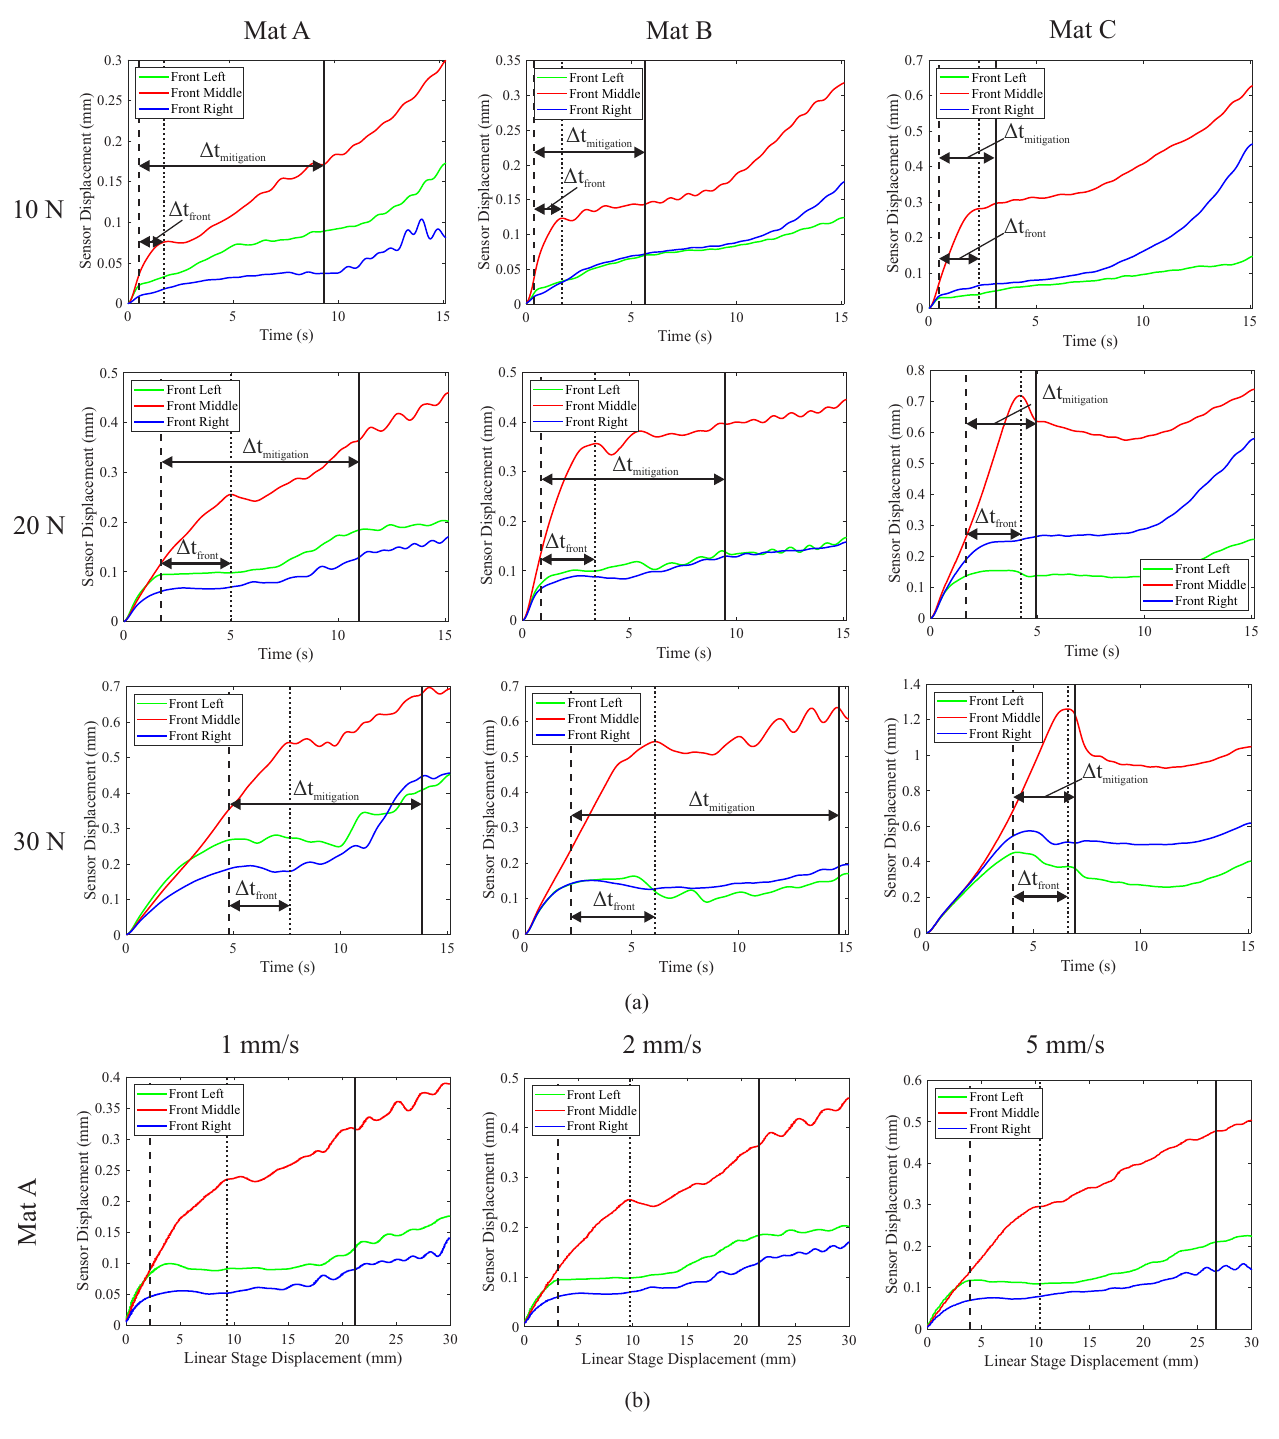
Figure 5. Graphs showing typical sensor displacements. The vertical dashed and dotted lines indicate the time slip was first detected at the outer and middle islands, respectively, whereas the solid vertical line indicates the time of macro slip. The horizontal arrows indicate the time difference between the detection of incipient slip and the occurrence of macro slip ( ∆ t mitigation ), and the time between the detection of incipient slip of one of the front outer islands and the front middle island ( ∆ t front ). ( a ) Sensor displacement vs. time for changes in force and material stiffness at a retraction speed of 2 mm/s. ( b ) Sensor displacement vs. linear stage displacement (retraction distance) for variations in retraction speed for Mat A under a 20 N clamping